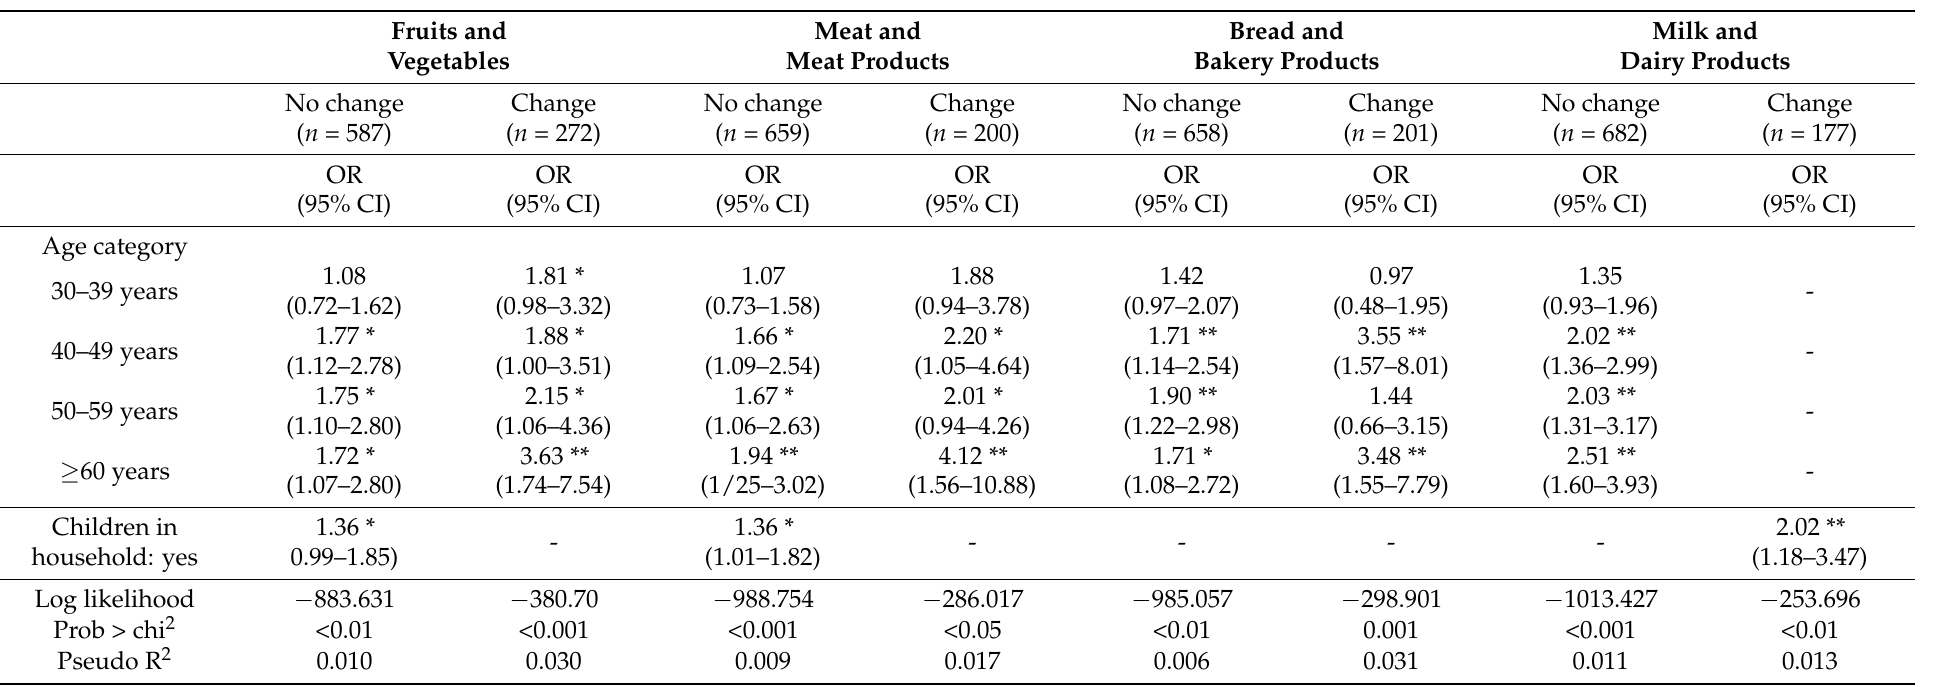
Table 3. Ordered logistic regression results—dependent variable: “I choose to shop directly from producers at the expense of